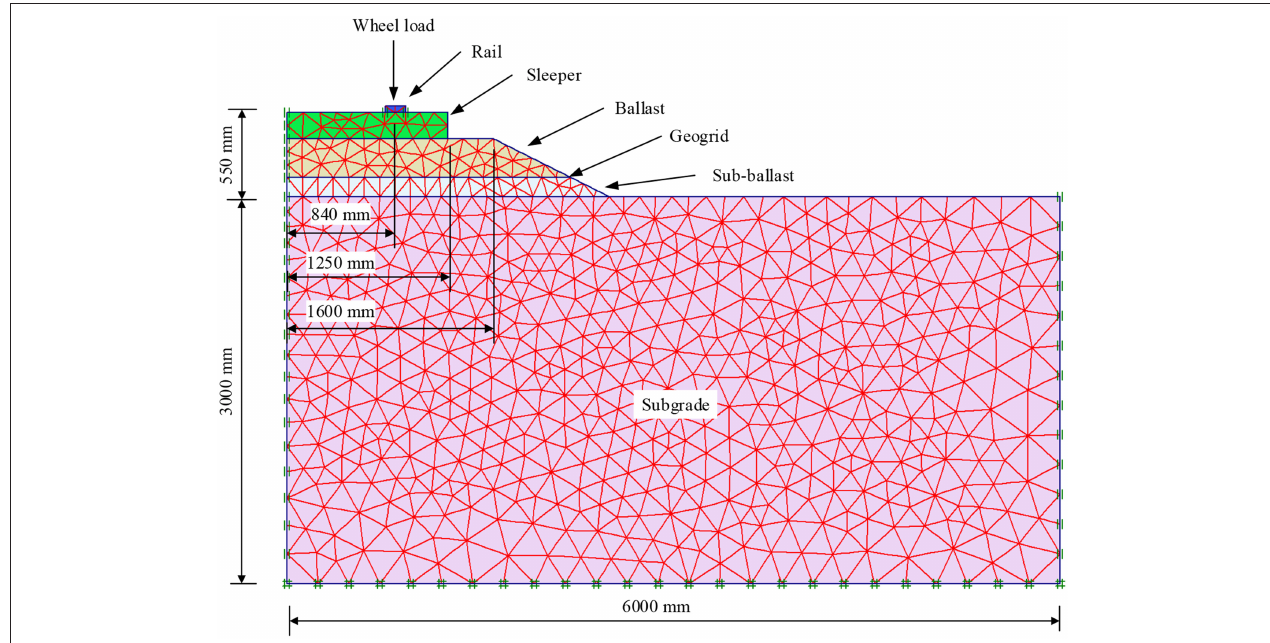
FIGURE 1 | Finite element mesh discretization of a rail track substructure.